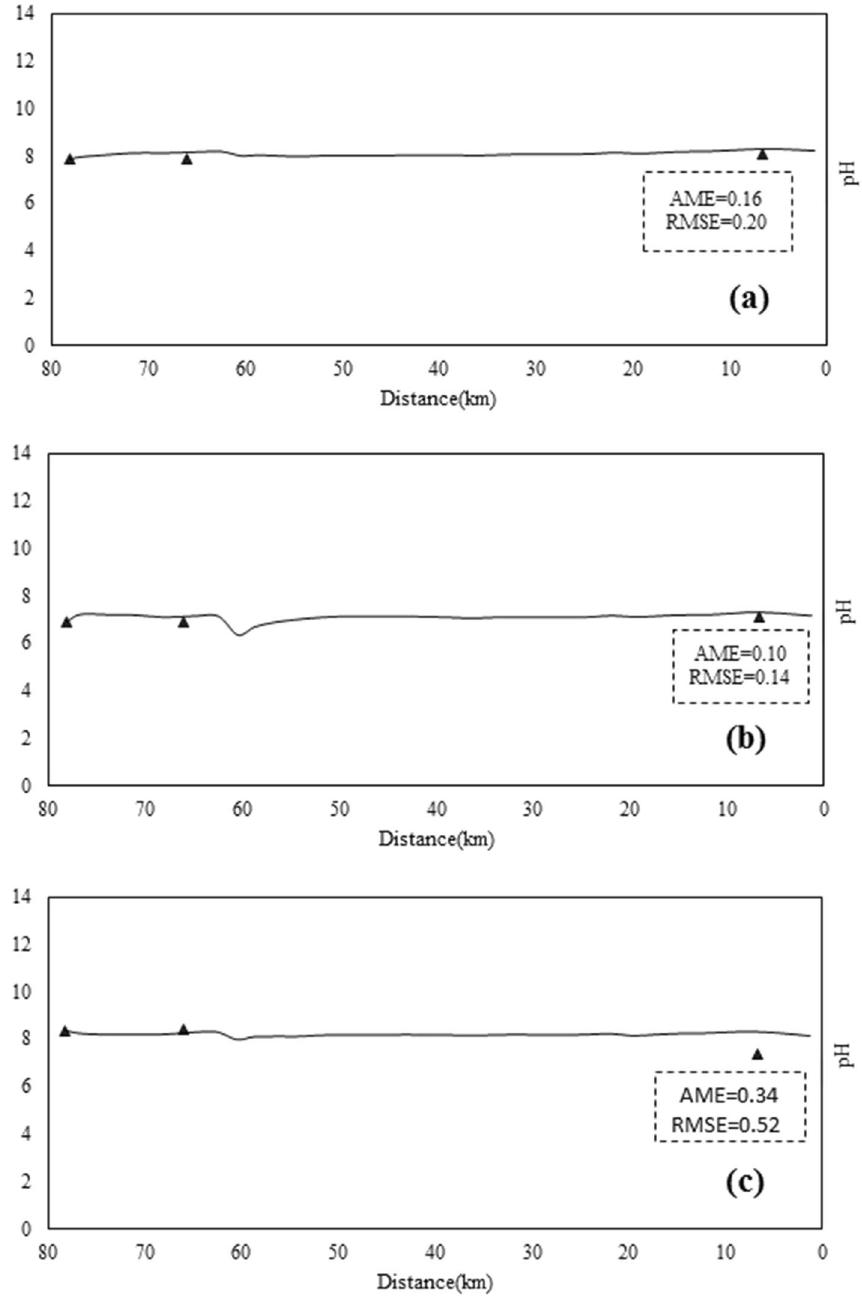
Figure 9. Total pH of Sarouq River in ( a ) spring, ( b ) autumn, ( c ) winter after calibration.